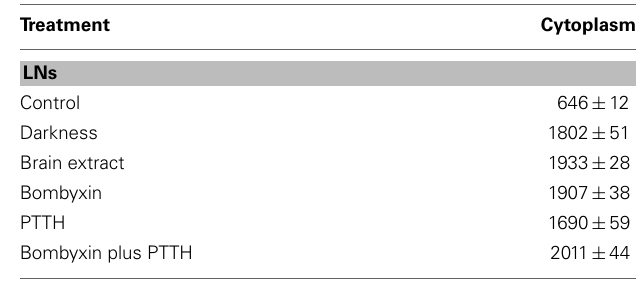
Table 5 | Mean relative PER fluorescence ± SEM in LNs following various in vitro